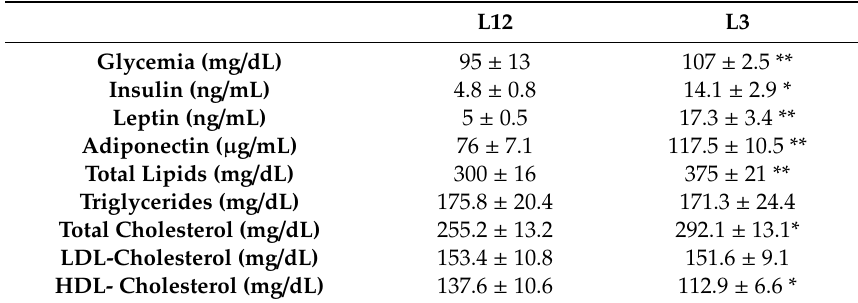
Table 2. Glycemia and plasma levels of insulin, leptin, adiponectin, triglycerides, total cholesterol, LDL cholesterol, and HDL cholesterol from L12 (lean) and L3 (overfed)